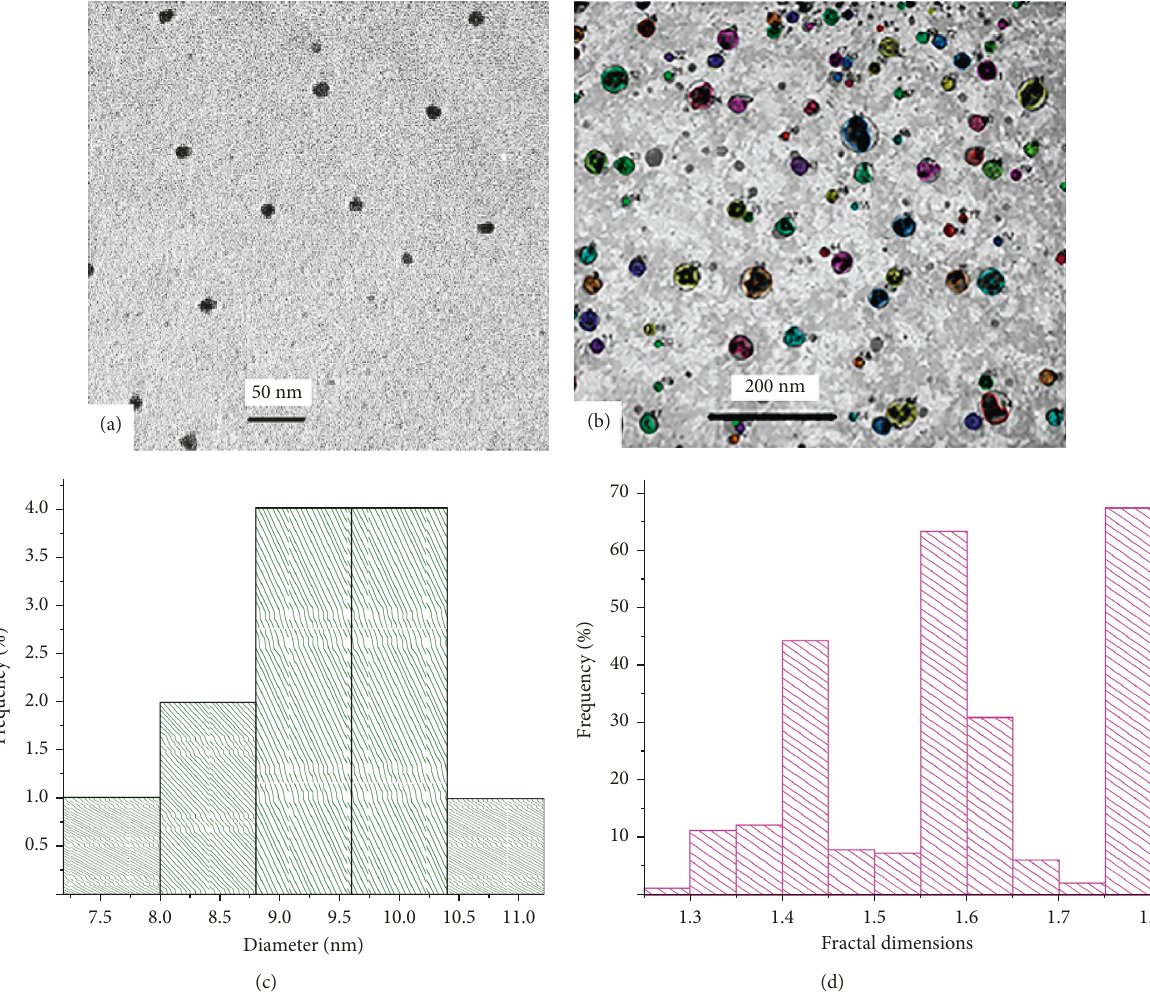
Figure 1: Multicomponent nanoparticles synthesized with the mortiño berry extract: (a) TEM image, (b) TEM image analyzed with MATLAB software, (c) DLS size distribution, and (d) fractal